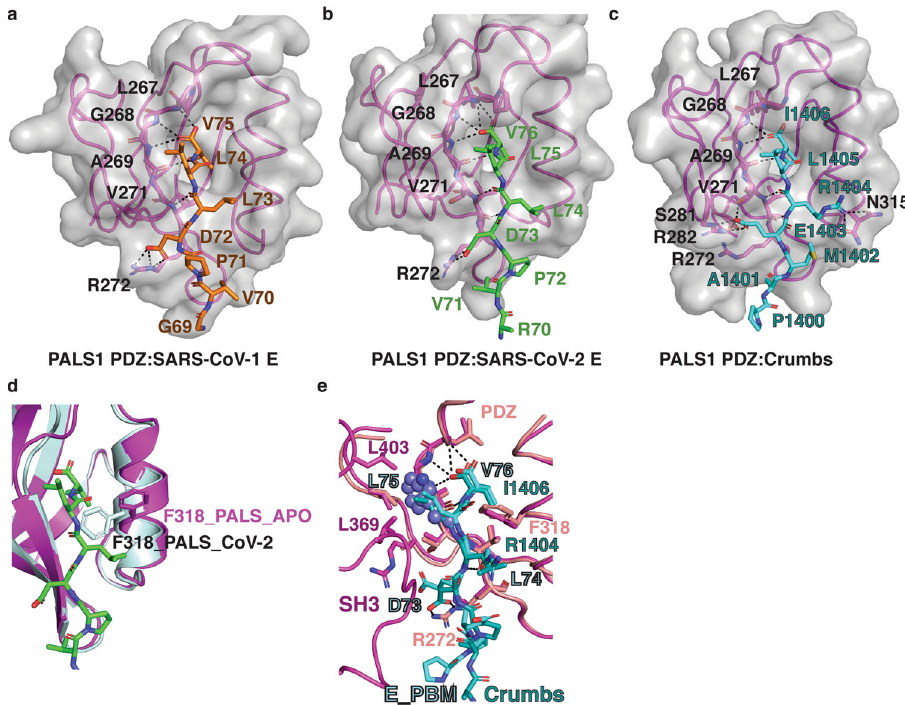
Fig. 3 Detailed view into the interfaces of PALS 1 PDZ bound to SARS-CoV-1 and SARS-CoV-2 E protein PBM. a – c Detailed view of interactions in the binding groove of PALS1 PDZ in complex with a , b SARS-CoV-2 E protein PBM peptide (green) or SARS-CoV-1 E protein PBM peptide (orange) or c Crumbs PBM peptide (cyan) (PDB ID 4UU5) 29 . Residues involved in hydrogen bonds or ionic interactions (shown as black dotted lines) are labelled. d Superimposition of PALS1 PDZ:SARS-CoV-2_E_PBM (magenta cartoon and green sticks) and apo-PALS1 PDZ (light blue). The orientation of the gatekeeper F318 is shown as sticks. e Superimposition of PALS1 PDZ:SARS-CoV-2_E_PBM with PALS-PDZ-SH3-MAGUK:Crumbs_PBM complex. PALS1 PDZ:SARS-CoV-2_E_PBM is shown as pink cartoon and sticks or cyan sticks, respectively. PALS-PDZ-SH3-MAGUK (PDB ID 4WSI) 23 is shown as light pink cartoon and sticks. Dm Crumbs_PBM is shown as dark cyan sticks. Key residues are labelled, and key hydrogen or ionic bonds are denoted by black dashed lines. The modelled Trp 81 from MERS CoV E PBM is shown as steel blue